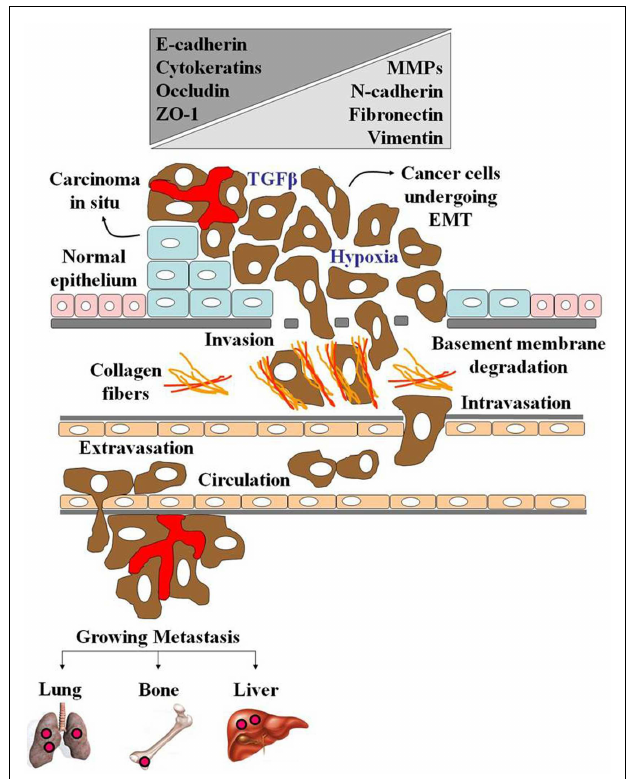
FIGURE 3 |The epithelial–mesenchymal transition . EMT is a morphogenetic process in which epithelial cells lose their characteristics and gain mesenchymal properties during embryogenesis and during progression of cancer. Carcinoma cells acquire a mesenchymal-like state in order to facilitate their migration and invasion.The EMT process is induced and regulated by effectors such as growth factors (TGF β ), as well by hypoxia. It is characterized by loss of epithelial markers (E-cadherin, cytokeratins, occludin, and ZO-1), gain of mesenchymal markers (N-cadherin, vimentin, and fibronectin) and high expression of MMPs, which help cancer cells grow and spread.